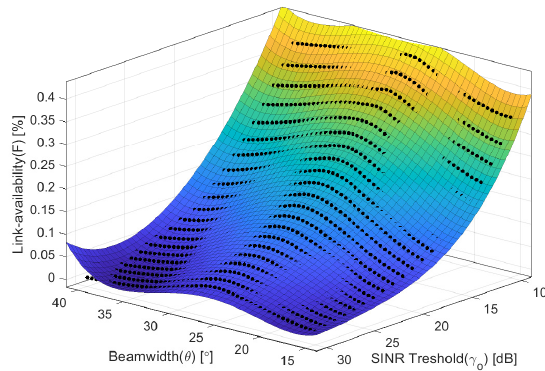
Figure 8. Uplink-SINR during the accessible period with different antenna beamwidths of the satellite. The grey line represents the SINR threshold, and the period when SINR is above the threshold represents the available period for communication.